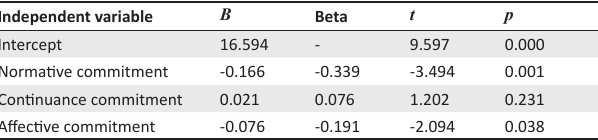
TABLE 12: Results of multiple regression model with intention to quit as a dependent variable and subscales of team commitment as independent